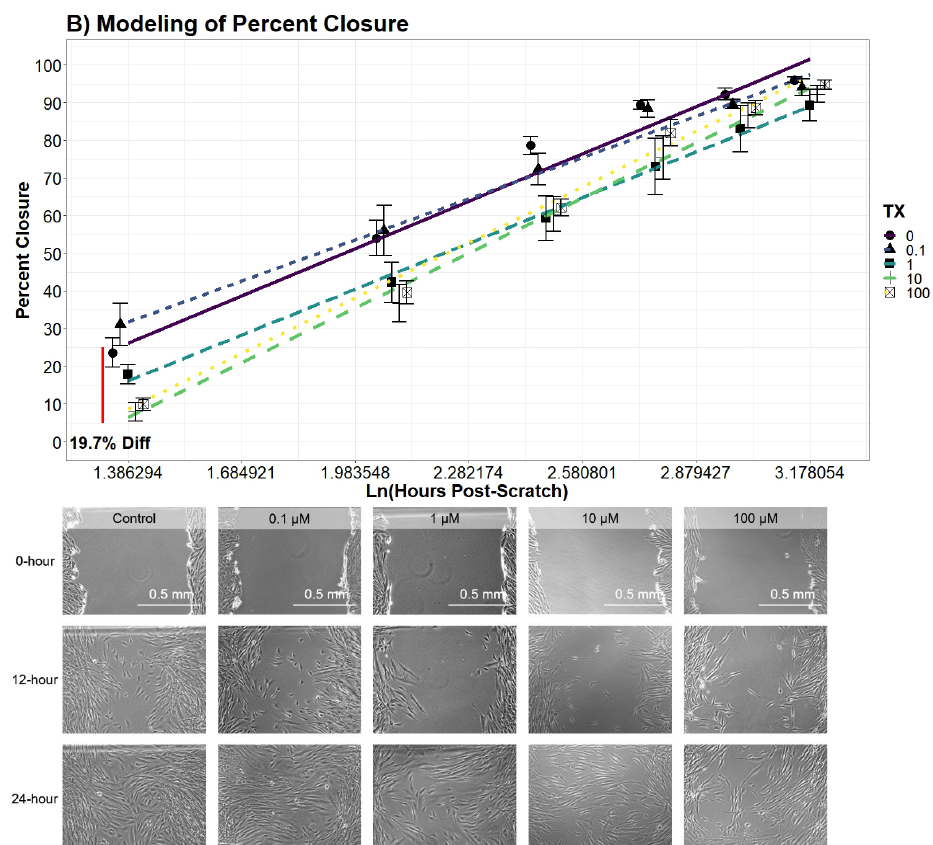
Figure 6. ( A ) Percent closure differences over a 24 h scratch assay (n = 8 for each condition). Contrasts were performed by a Tukey pairwise t -test across significant variables from an additive two-way ANOVA. Significance bars, marked with “ * ”, refer to significant Tukey pairwise t -tests between the conditions at the beginning and the end of the bar. ( B ) Interaction modeling of percent closure across treatments (R 2 = 0.8663). Displayed points represent the mean of each group ± StdErr. Red vertical adj line represents largest difference observed 4 h post-scratch between control and 10 µ M. Inverted light microscopy of hDFn migration at 0, 12, and 24 h post scratch (100 × total magnification). All initial scratch widths were 1 mm ± 0.1 mm, with no significant differences of beginning scratch width at hour